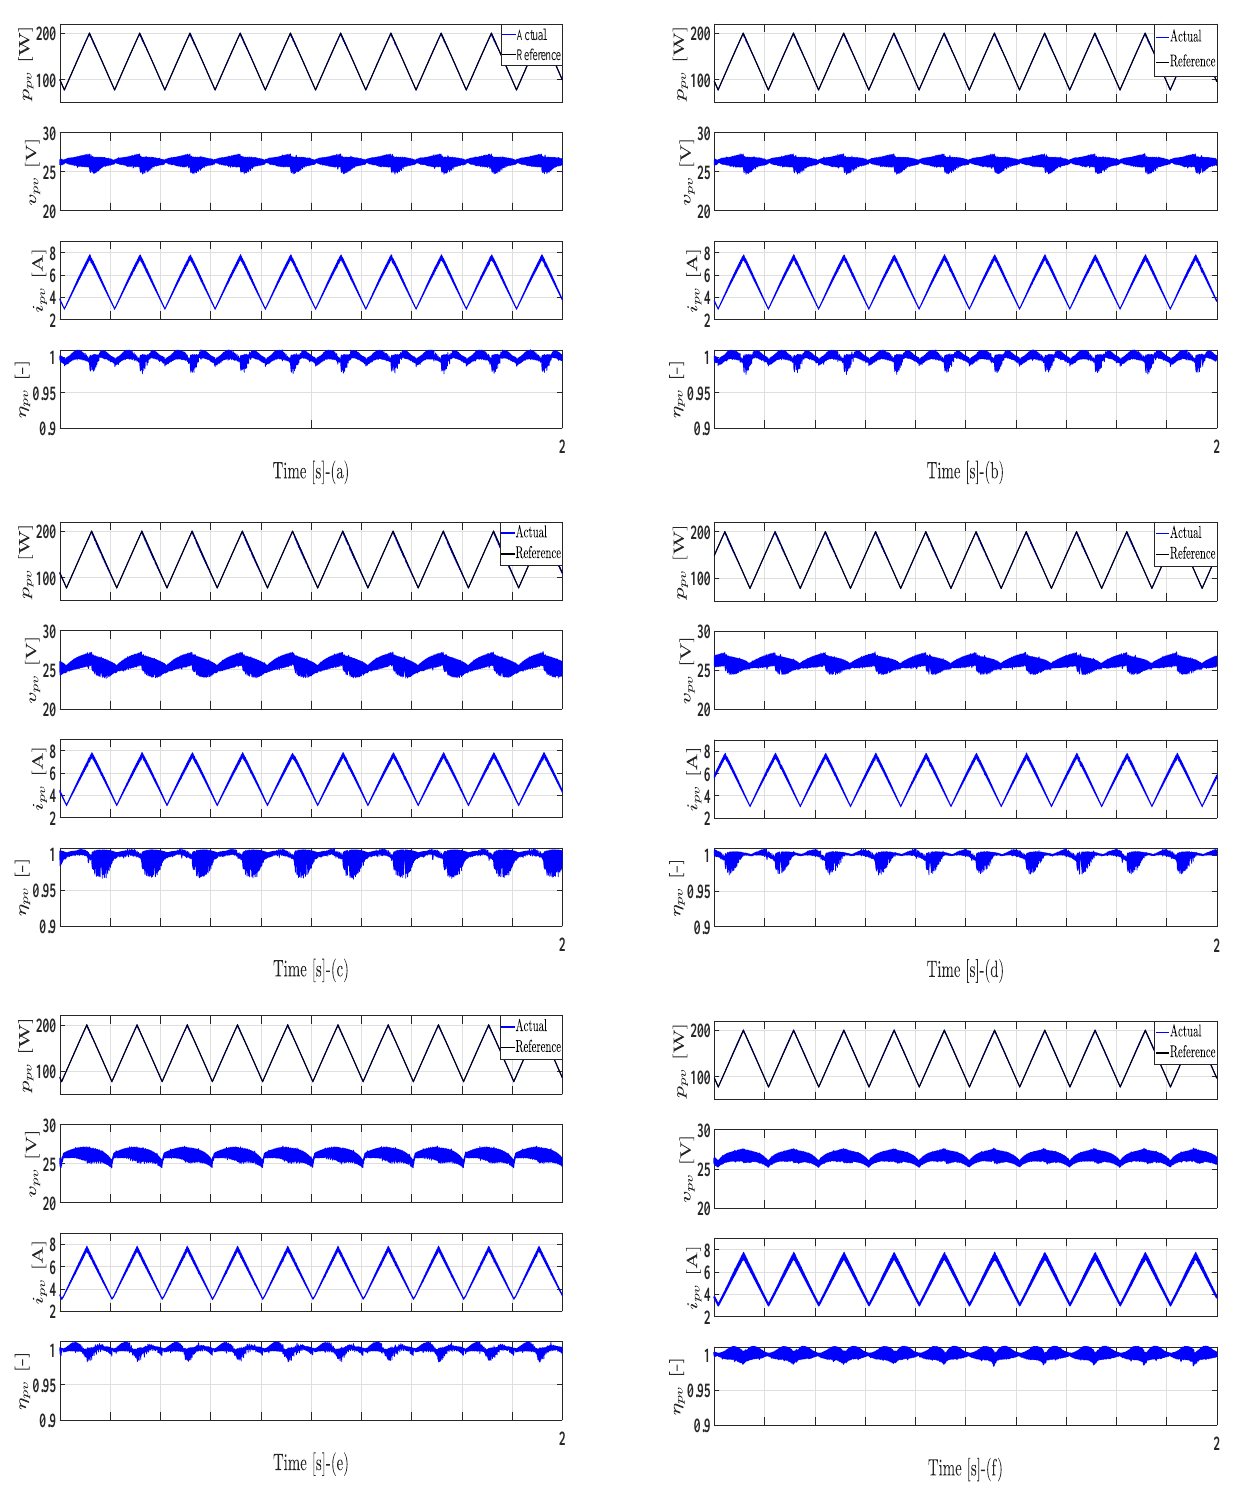
Figure 7. The performance of model-based MPPT methods at dynamic variations of radiation (zoomed view). ( a ) Constant voltage method, ( b ) temperature method, ( c ) voltage-based method (V1), ( d ) voltage-based technique (V2), ( e ) current-based algorithm, ( f ) curve fitting